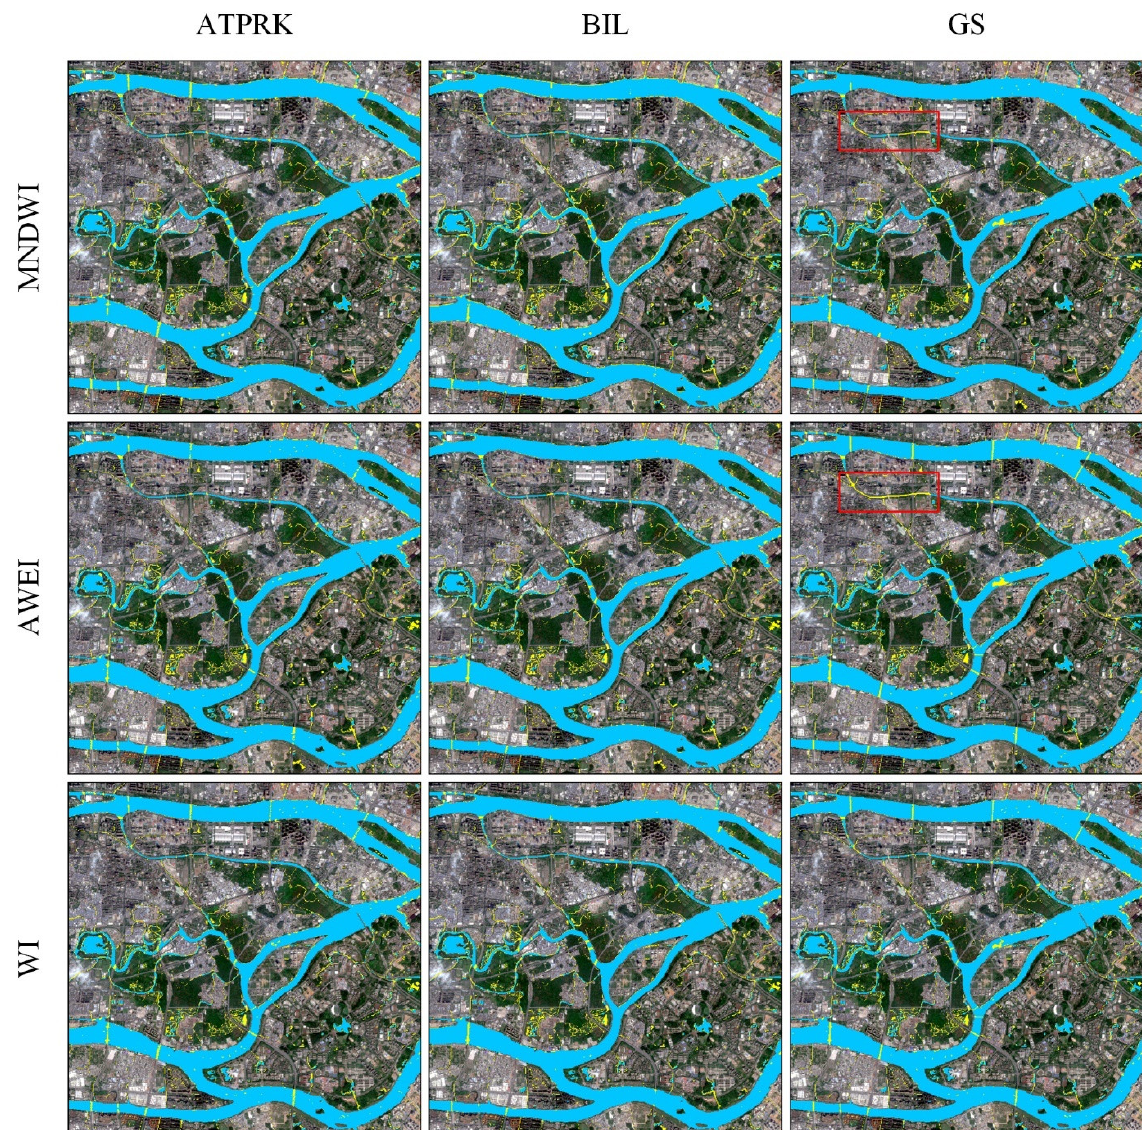
Figure 7. Unidentified results of water bodies for different combinations of water indices and downscaling methods, e.g., omission errors of a small stream in the red box. downscaling methods, e.g., omission errors of a small stream in the red